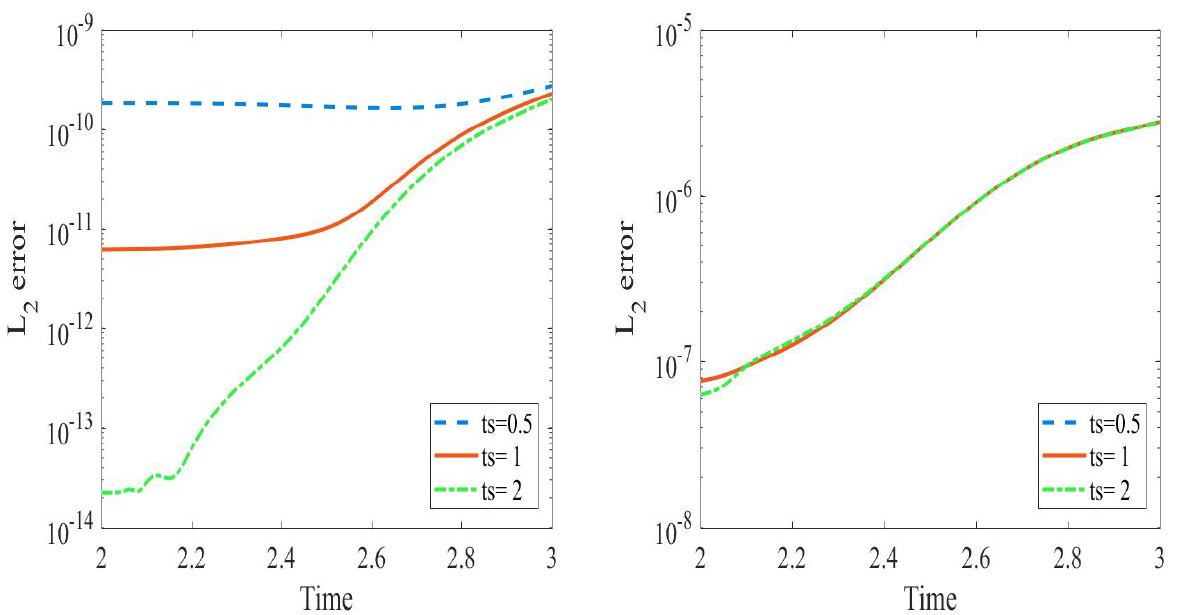
Figure 11. Mean and variance with different numbers of modes.   =